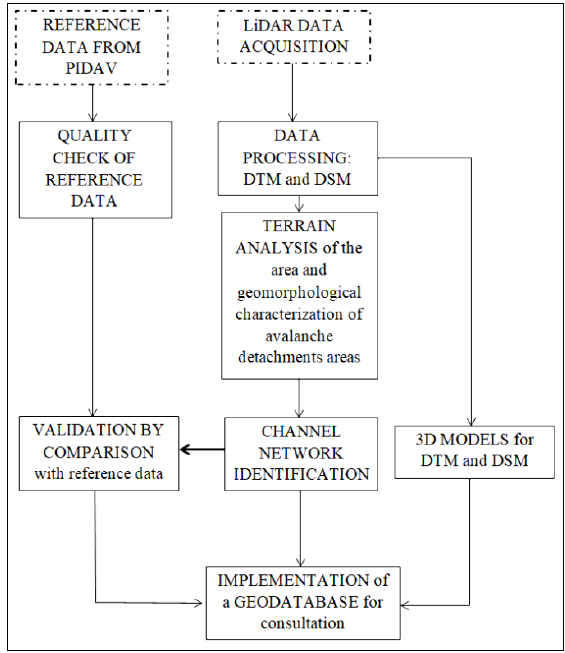
Figure 3. Flowchart of adopted workflow.